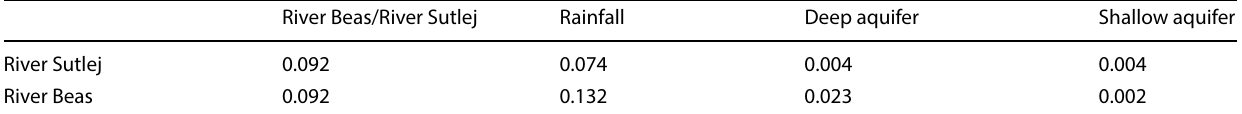
Table 2 The Kendall’s correlation coefficient (τ) value by comparing d-excess of the river Sutlej, the river Beas, the rainfall, the deep aquifer, and the shallow aquifer